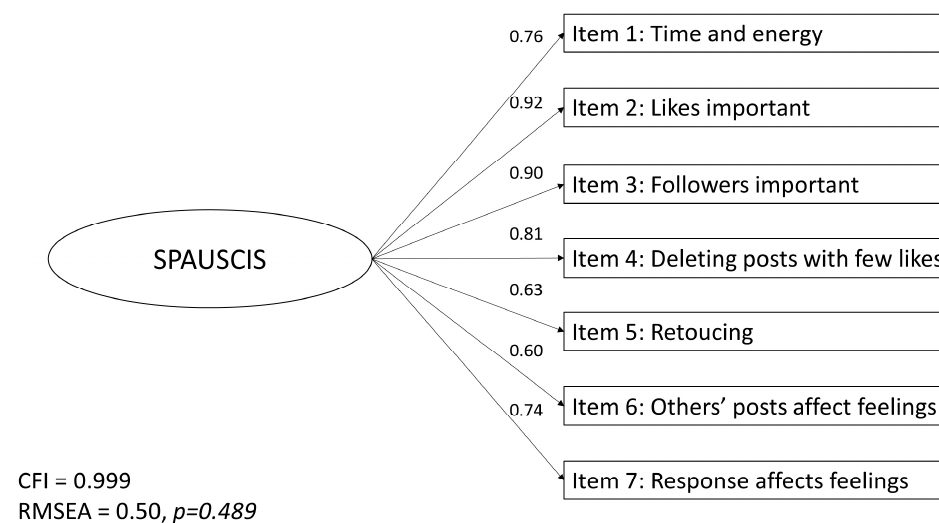
Figure 1. Results of the confirmatory factor analysis: One-factor model with the items “easier to be myself” and “I don’t care” deleted. CFI = Comparative Fit Index, RMSEA = root mean square error of approximation, SPAUSCIS = Self-presentation and Upward Social Comparison Inclination Scale.